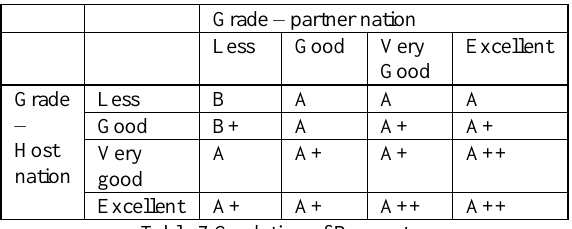
Table 7 Gradation of Parameters